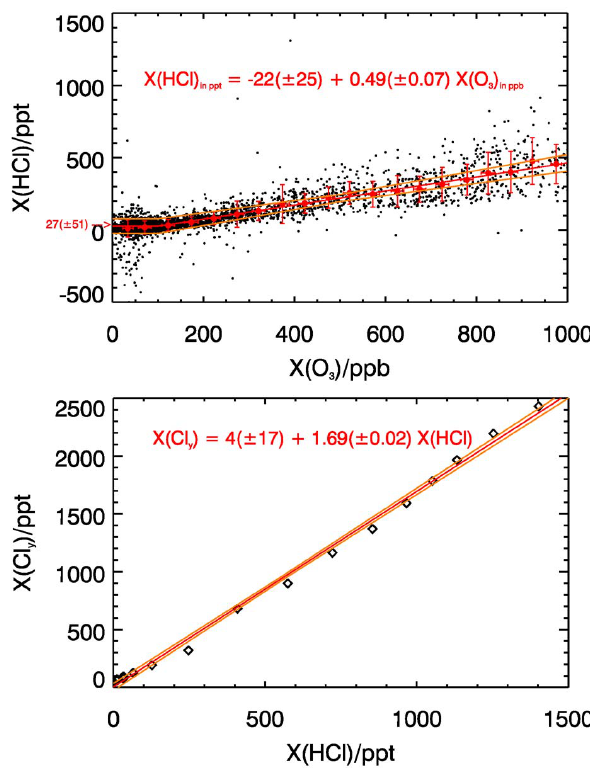
Fig. 1. Correlations used to estimate Cl y from O 3 . (a) Correlation of HCl vs. O 3 based on ACE-FTS satellite observations (Version 2.2-update) in the latitude band 30 ◦ N–30 ◦ S between November 2004 and February 2006 (black symbols) averaged in 50ppb O 3 bins (red symbols with 1 σ -error bars for HCl and O 3 ) . (b) Corre- lation of Cl y vs. HCl based on the tropical (30 ◦ N–30 ◦ S) chlorine inventory (based on ACE-FTS measurements of a large number of inorganic and organic chlorine containing trace gases from Febru- ary 2004–January 2005) recently published by Nassar et al.